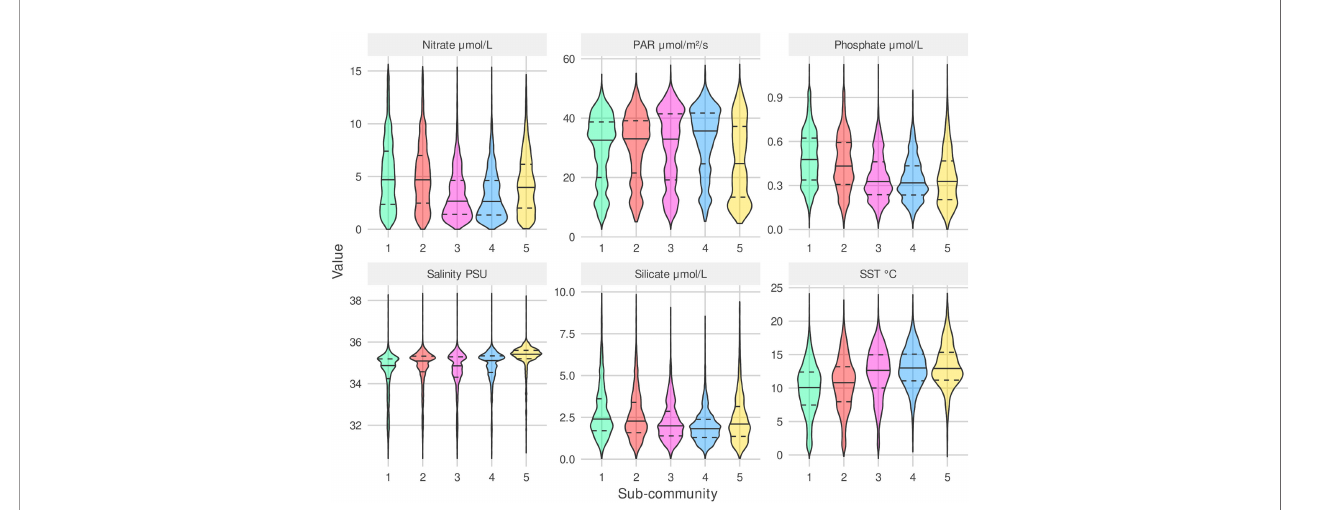
FIGURE 5 | Sub-community niches . Violin plots (including median (solid), 25% and 75% percentiles(dashed)) for six environmental variables over samples where each sub-community is determined to be present (samples containing least 30% (rounded down) of a sub-community ’ s members). Sub-community colors and numeric-labels match the colored regions and labels of Figure 2 .